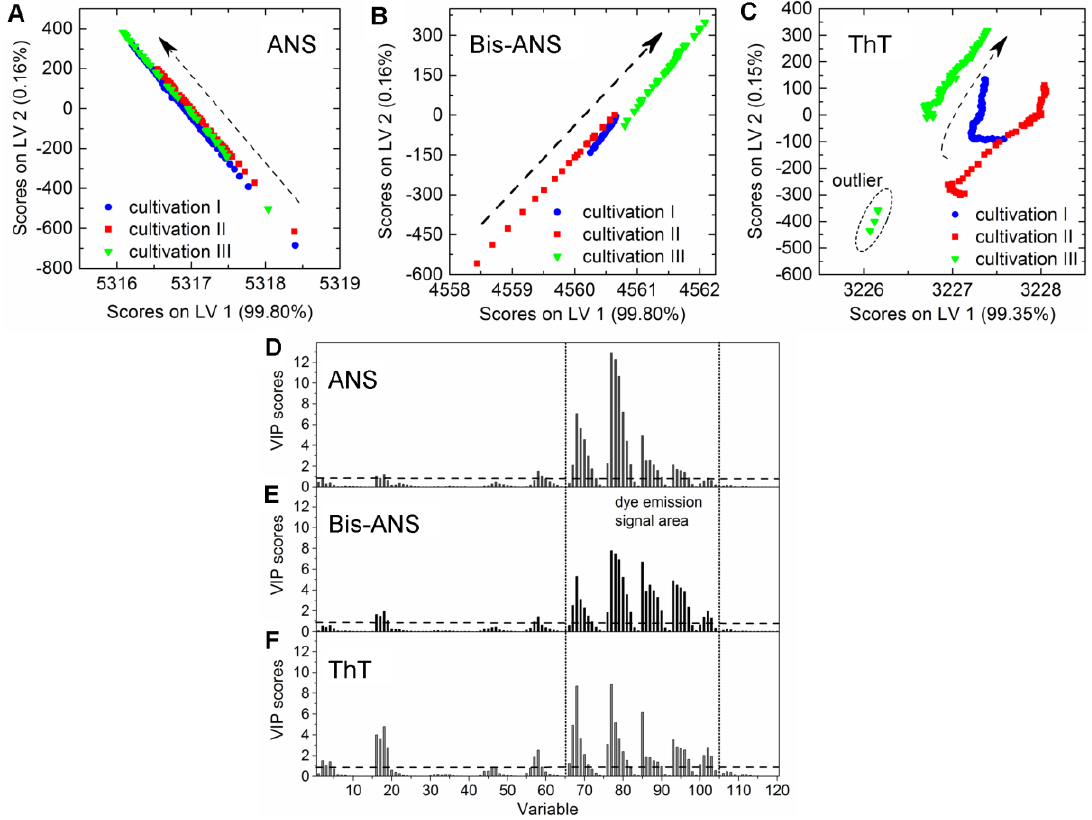
Figure 2. Scores plots of the PLS models for the prediction of aggregated mAb containing either ( A ) 100 µ mol · L − 1 ANS; ( B ) 2 µ mol · L − 1 Bis-ANS; or ( C ) 2 µ mol · L − 1 ThT. Dashed arrows indicate the development of the trajectories over cultivation time (only every 20th data point is shown). Furthermore, corresponding variable importance in projection (VIP) scores plots of the respective PLSR models are given in ( D – F ), respectively. LV: latent